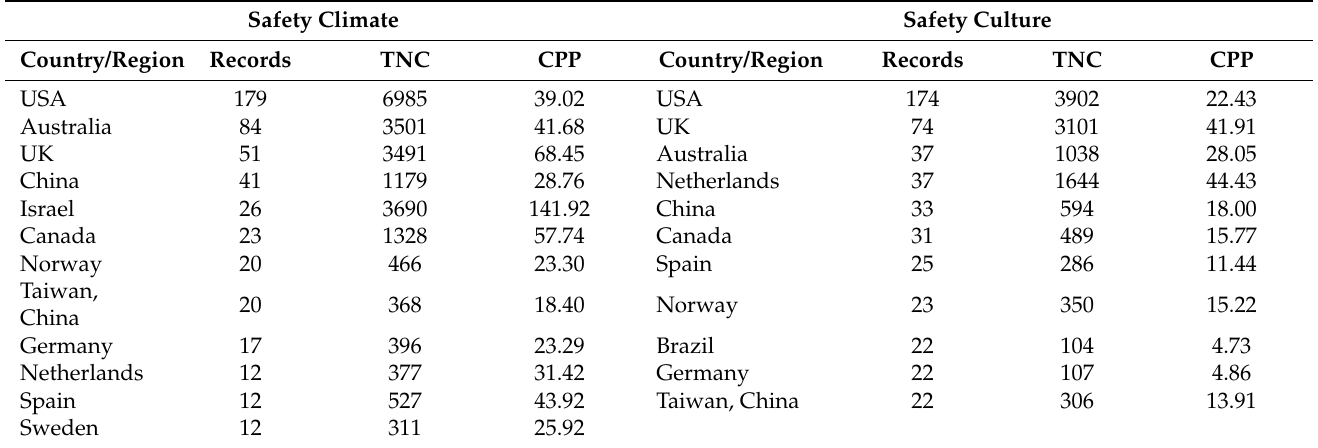
Table 2. Top 10 most productive countries/regions in safety climate and safety culture